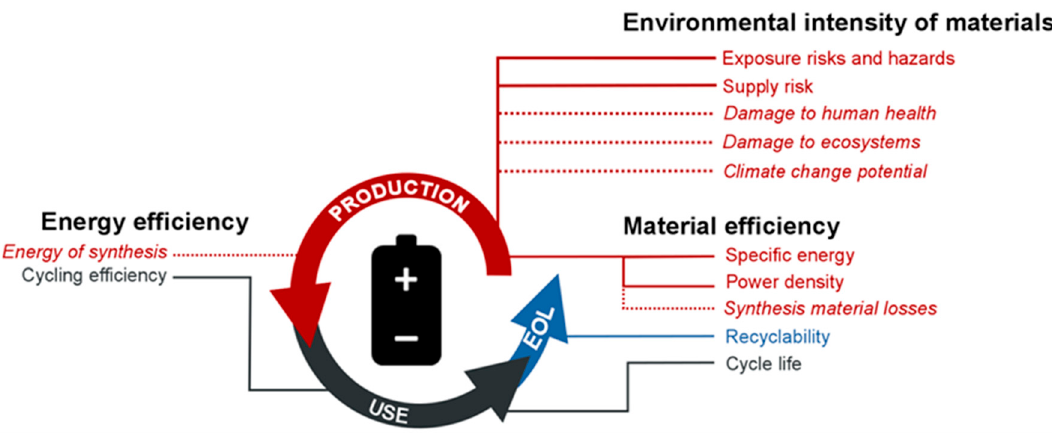
Figure 1. Lifecycle aspects of a stationary rechargeable battery. Solid lines denote intrinsic aspects of the material itself. Dotted lines and italic font denote extrinsic properties that are attributes of the value chain aspects or embodied activities related to the material’s production. Red lines denote production aspects, dark grey lines use phase aspects, and green lines end-of-life aspects. Abbreviation: EOL—end-of-life. Figure is adapted from [31].